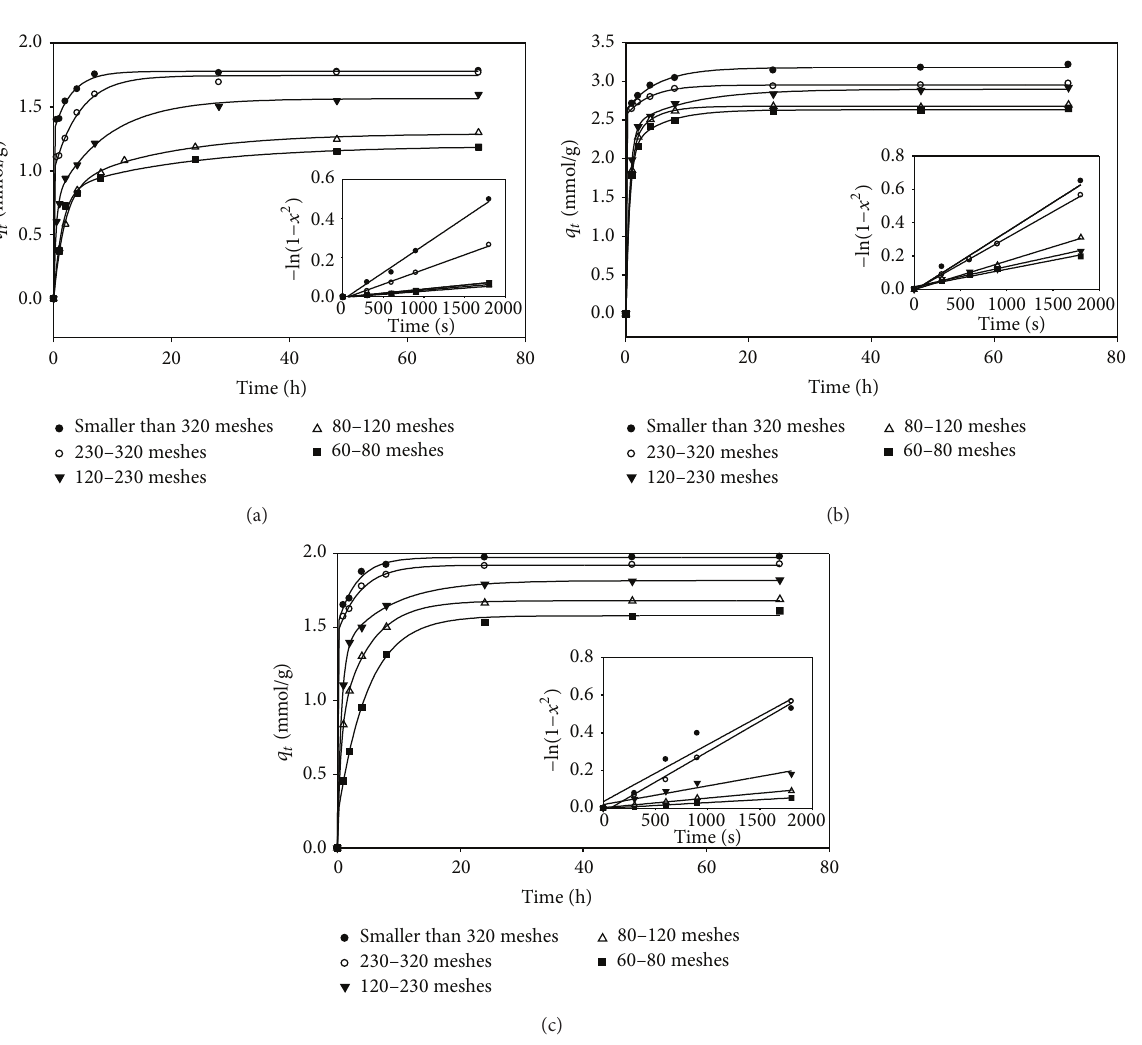
Table 2: Effective diffusion coefficient of acetaminophen, diclofenac, and sulfamethoxazole onto GAC. Particle size (mesh)